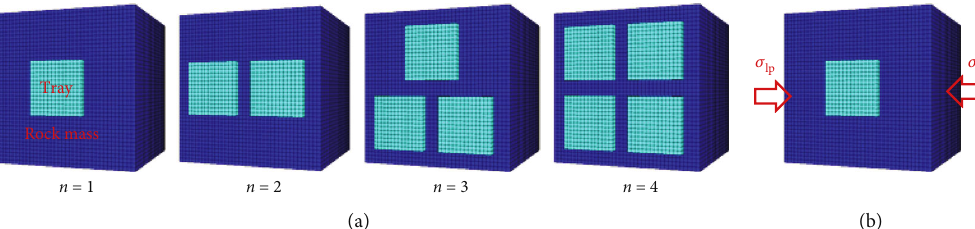
Figure 5: Numerical simulation mode of rock mass specimen with di ff erent (a) bolt number and (b) lateral pressure,